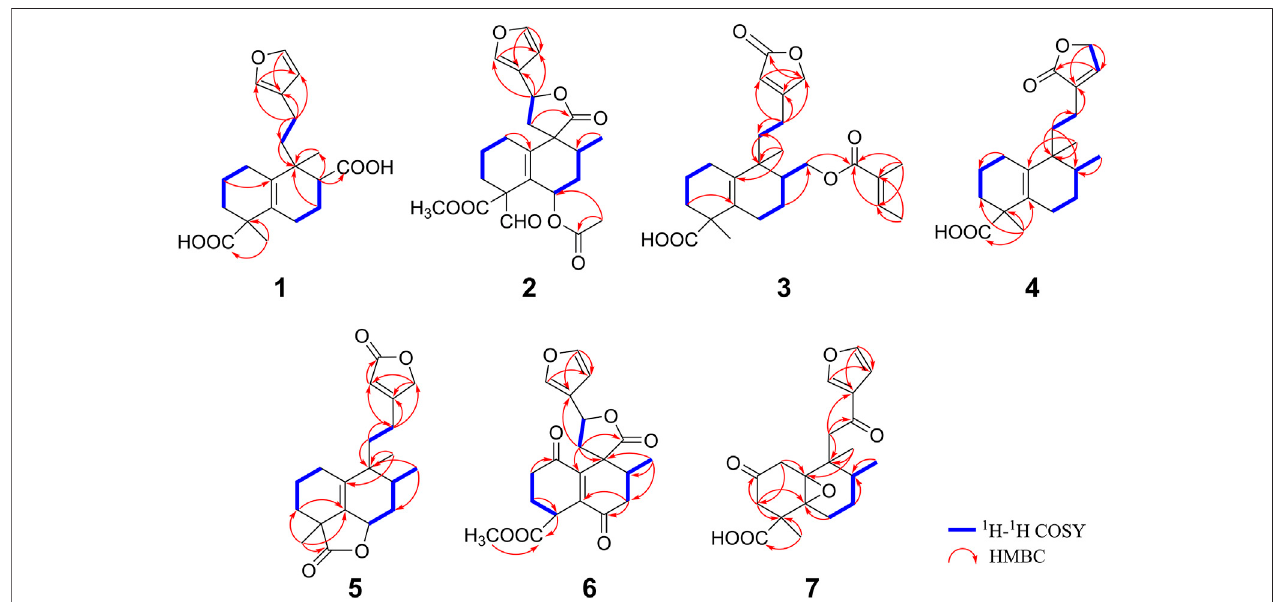
FIGURE 3 | Structures of compounds 1 – 12 .